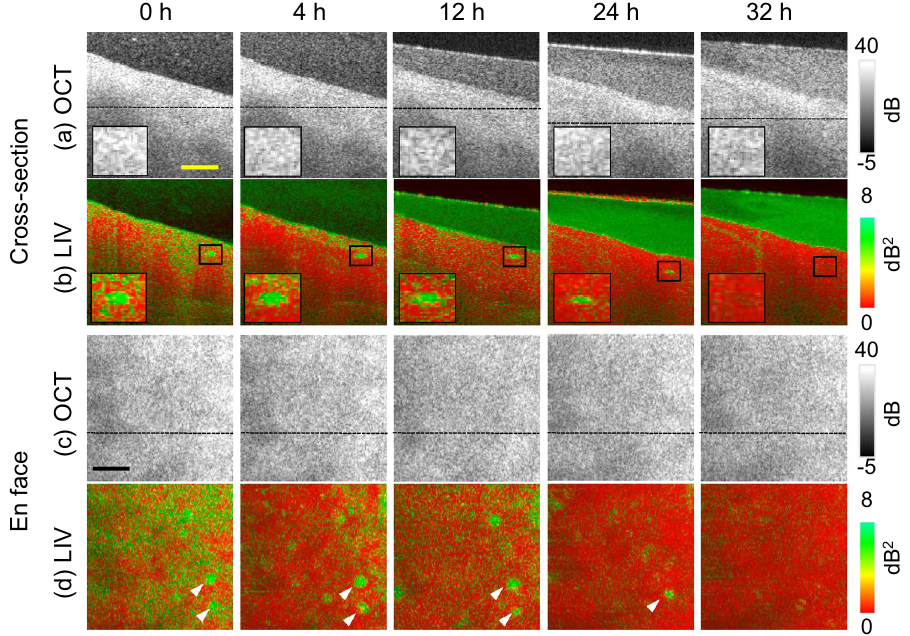
Figure 7. Longitudinal dynamics visualization of early fibrotic liver microvasculature. The first and second rows ( a , b ) represent the cross-sectional OCT and LIV images, whereas the third and fourth rows ( c , d ) show the en face OCT and LIV images, respectively. The first to fourth rows show time-course images at the 4, 12, 24, and 32 h time points. Scale bar: 250 μm.